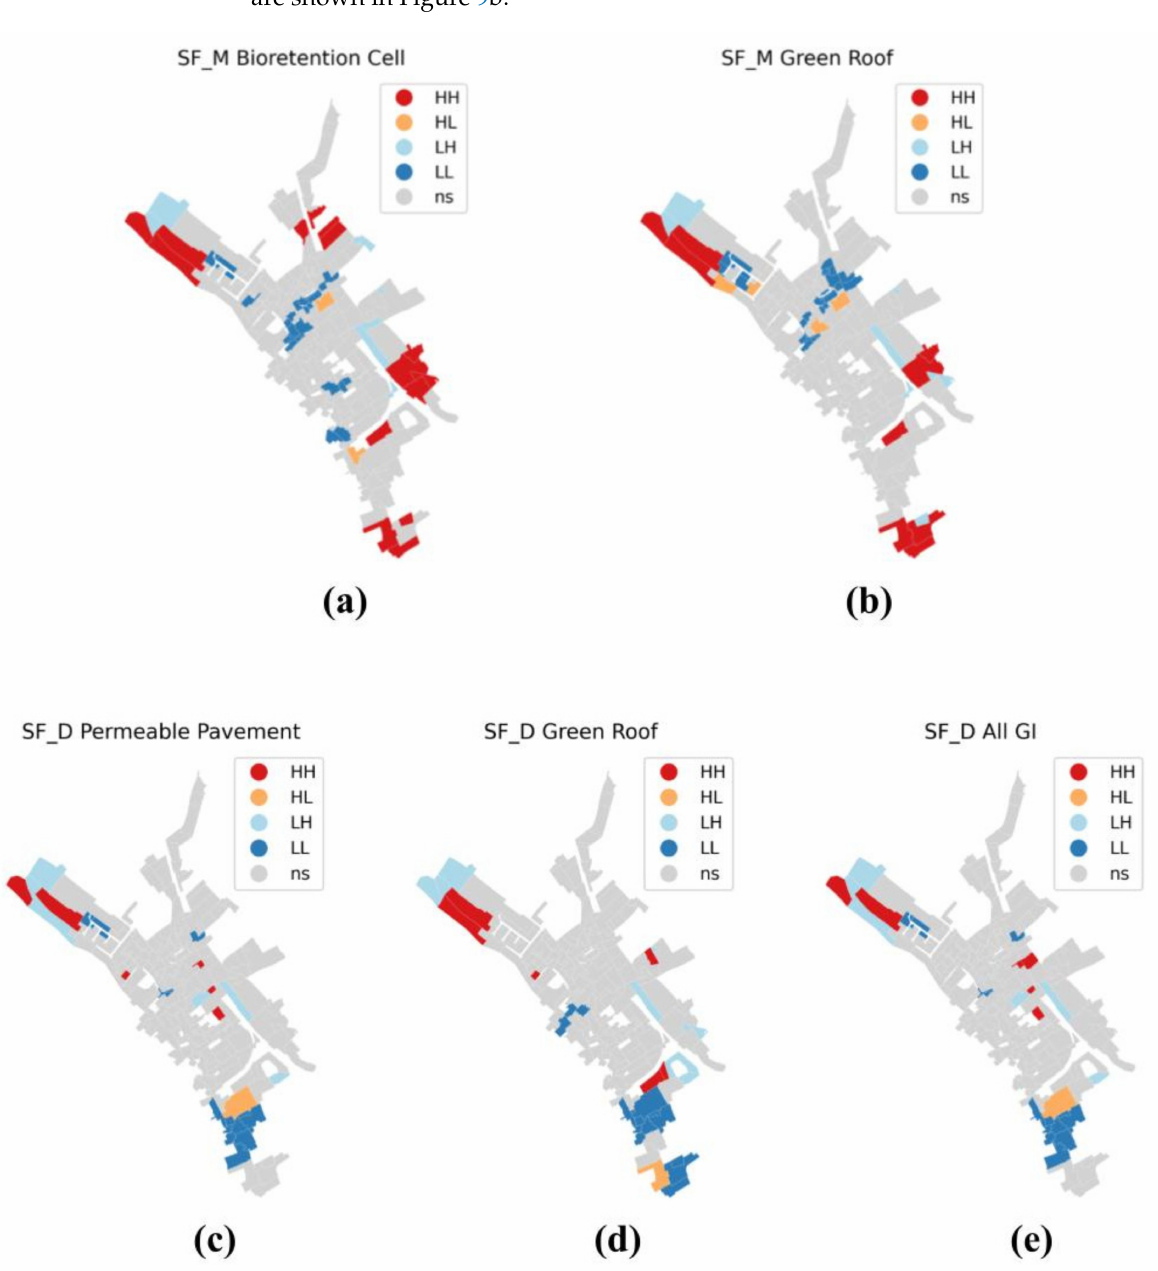
Figure 8. LISA cluster map for GI impacts in resilience enhancement. HH—High-high cluster. HL—High-low cluster. LH—Low-high cluster. LL—low-low cluster. ns: statistically not significant. Level system failure: Sewer flooding. ( a ) LISA cluster map for the bioretention cell using sewer flooding magnitude (SF_M) as the resilience indicator. ( b ) LISA cluster map for the green roof using sewer flooding magnitude (SF_M) as the resilience indicator. ( c ) LISA cluster map for the permeable pavement using sewer flooding duration (SF_D) as the resilience indicator. ( d ) LISA cluster map for the green roof using sewer flooding duration (SF_D) as the resilience indicator. ( e ) LISA cluster map for “all GI” using sewer flooding duration (SF_D) as the resilience